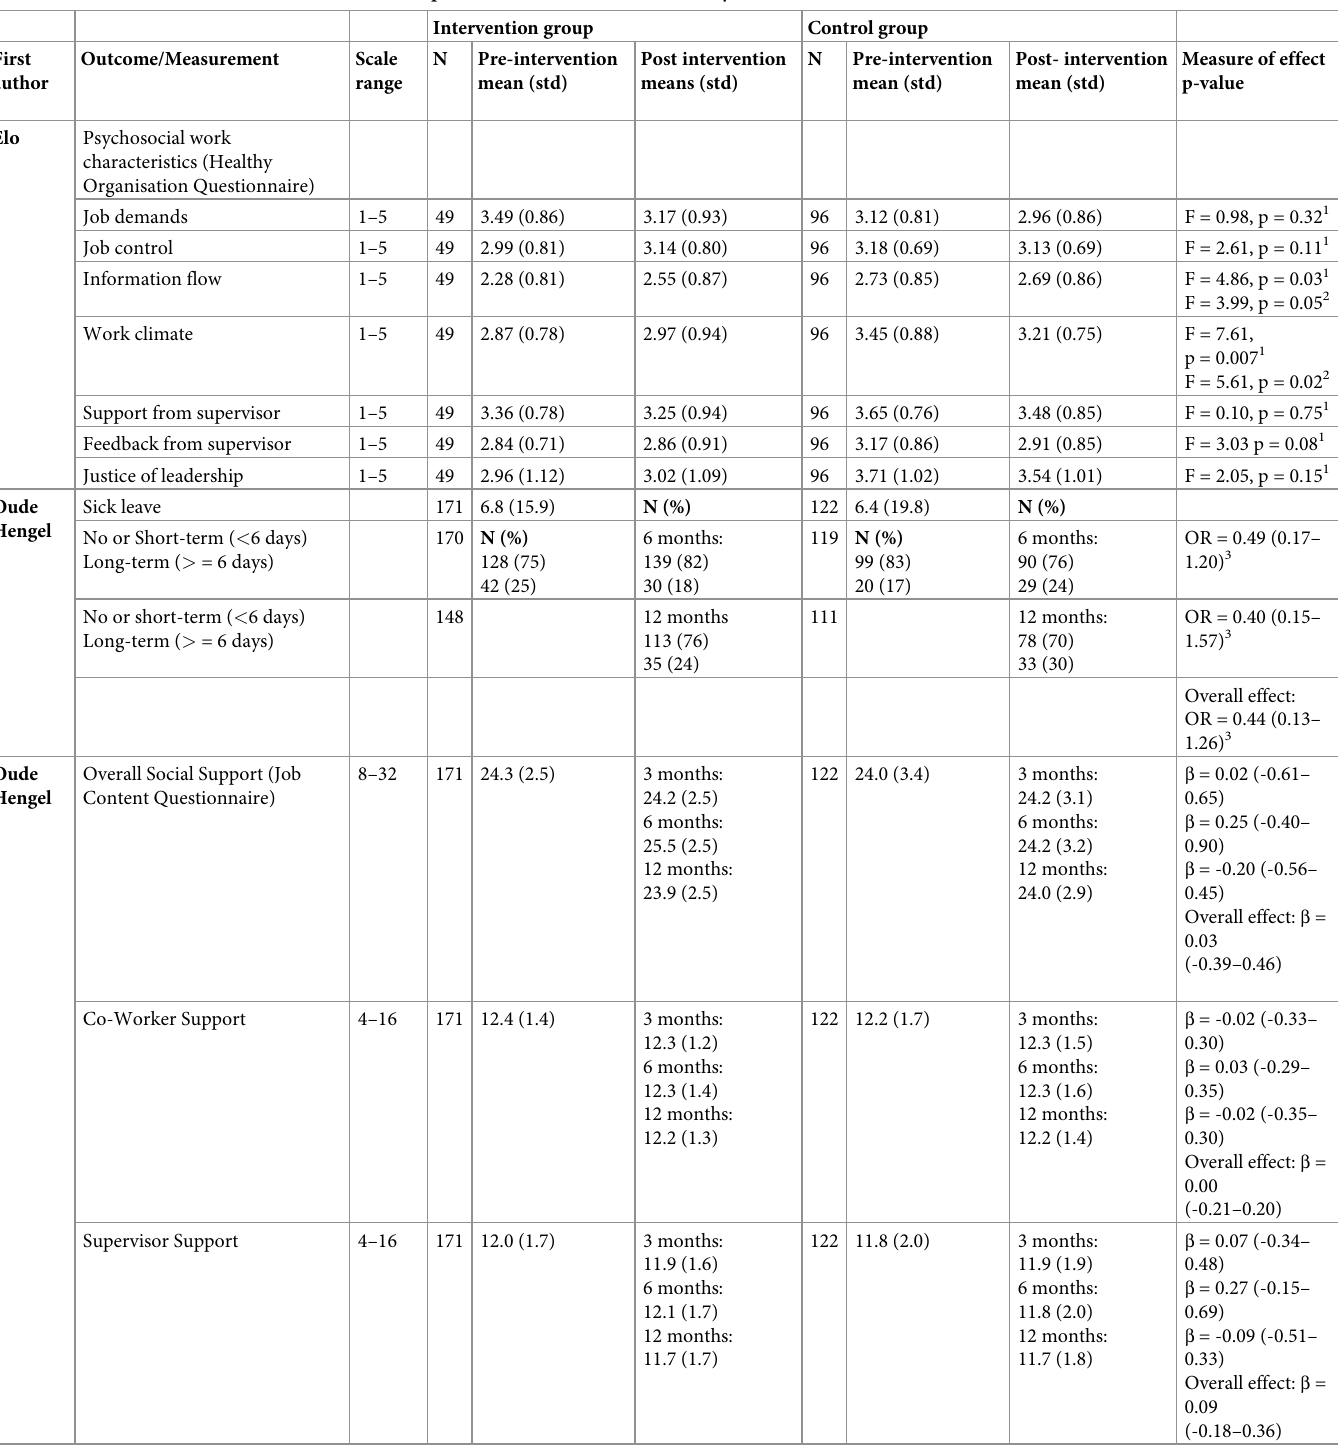
Table 6. Results of the effectiveness of mental health promotion interventions: Secondary